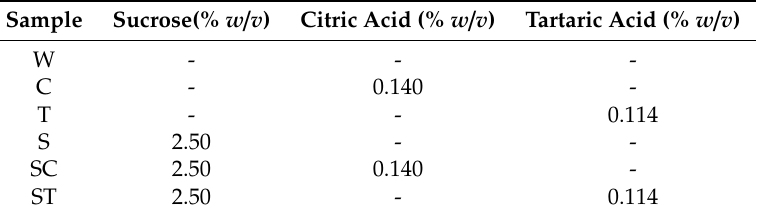
Table 1. Sample names and concentrations of tastants. Samples are Water (W), Citric acid (C), Tartaric acid (T), Sucrose (S), Sucrose and Citric acid (SC), and Sucrose and Tartaric acid (ST).